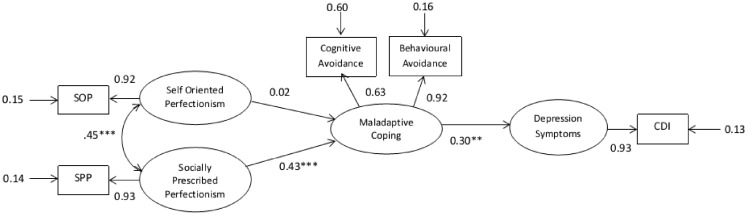
Gender controlled mediator structural equation model at pre-test. N = 541. *p < 0.05, two-tailed; **p < 0.01, two-tailed; ***p < 0.001.